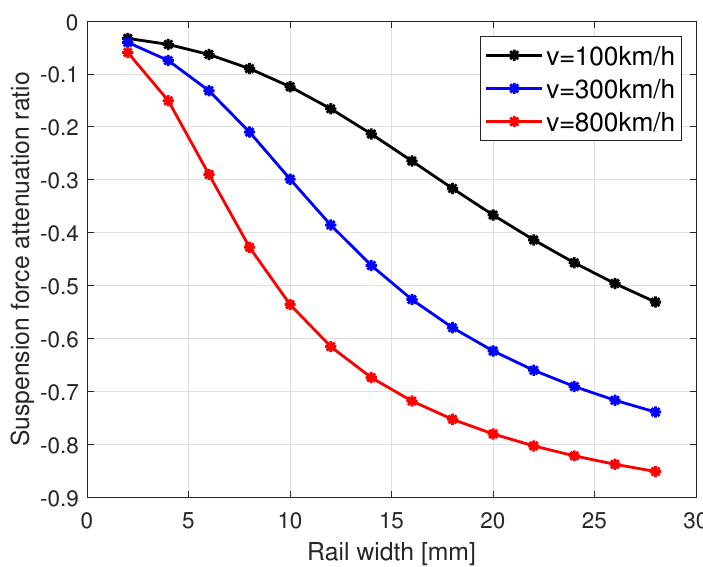
Figure 10. Variation of the suspension force with the rail